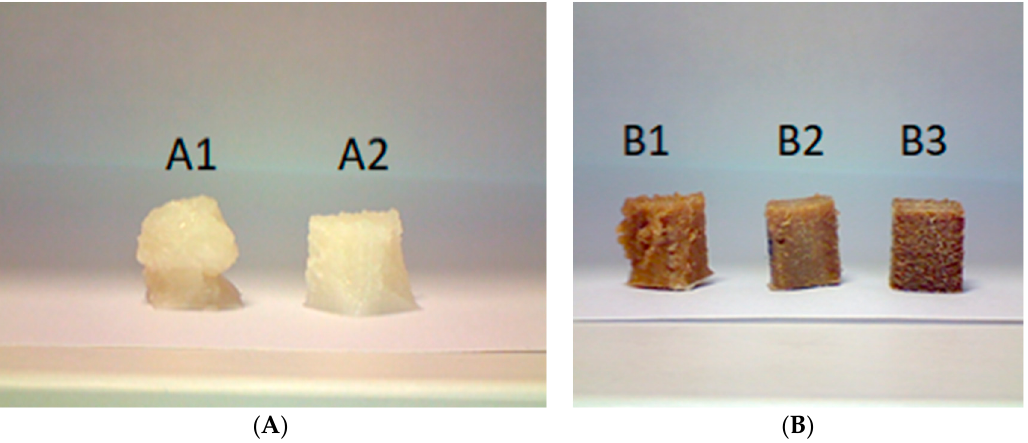
Figure 8. Cubic geometry of Typha-PBSA biocomposite.